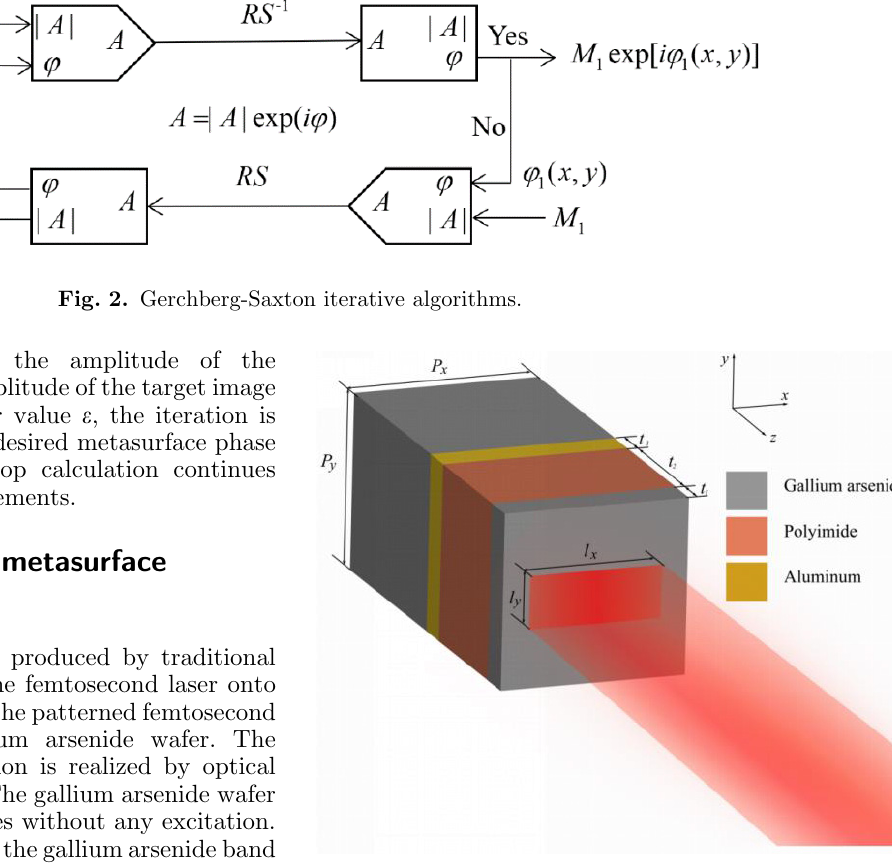
Fig. 3. Schematic diagram of dynamic controllable metasurface unit